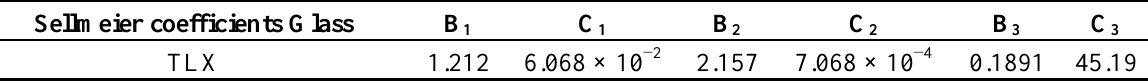
Table 2. Sellmeier coefficients of TLX